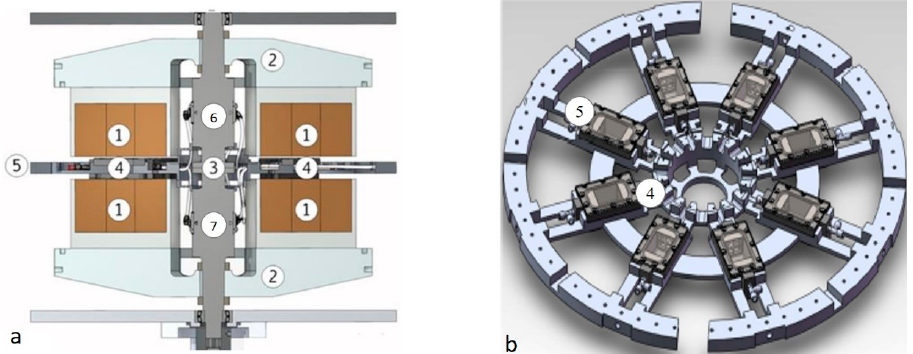
Figure 1. Prototype core details in cross-section ( a ) and 3-D view of MCW ( b ): (1) permanent magnet assembly; (2) magnets support; (3) shaft-rotary valve combination; (4) regenerators; (5) magneto caloric wheel (MCW); (6) cold sub-valve and (7) hot sub-valve. Table 1. Measurement instruments used for the experimental tests.